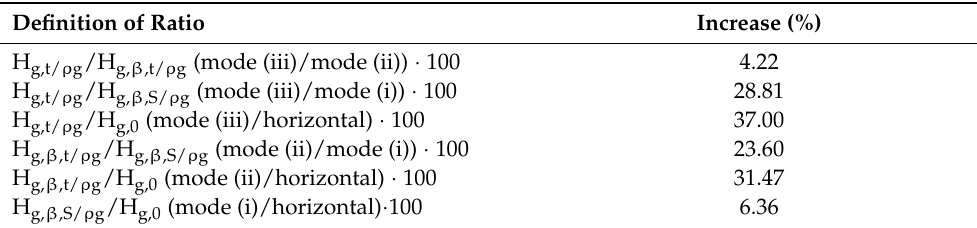
Table 4. Increase (in %) in the annual solar energy sums from all 82 sites in Saudi Arabia when using horizontal, mode (i) static, and modes (ii) and (iii) dynamic